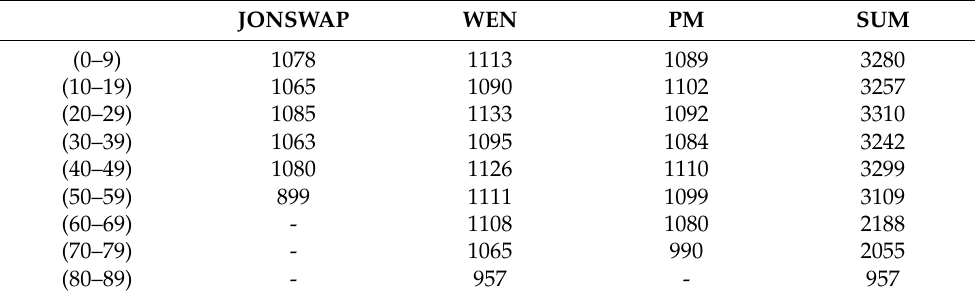
Table 2. The number of freak waves generated by the three wave spectra in different modulation intervals and the total number of generated freak waves in each interval. JONSWAP